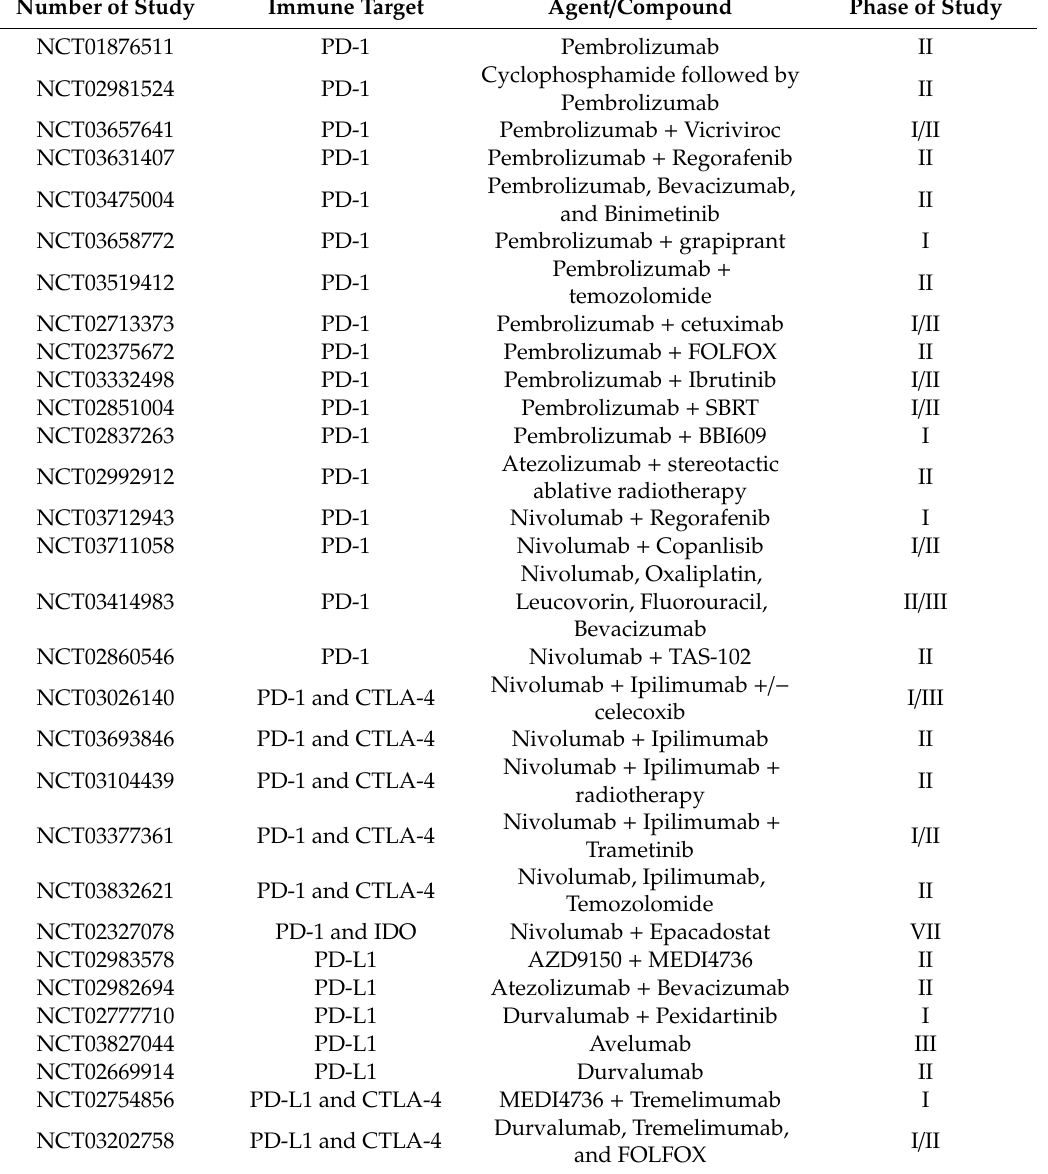
Table 1. Clinical studies with immunotherapy for patients with Please define this term if appropriate. Number of